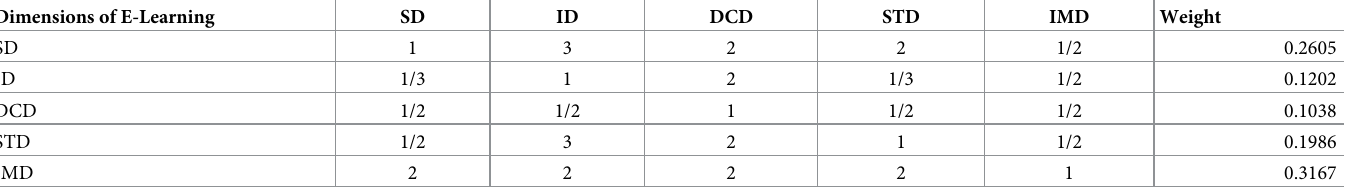
Table 5. A pairwise comparison of E-Learning dimensions by DM3 using AHP-GDM. Dimensions of E-Learning